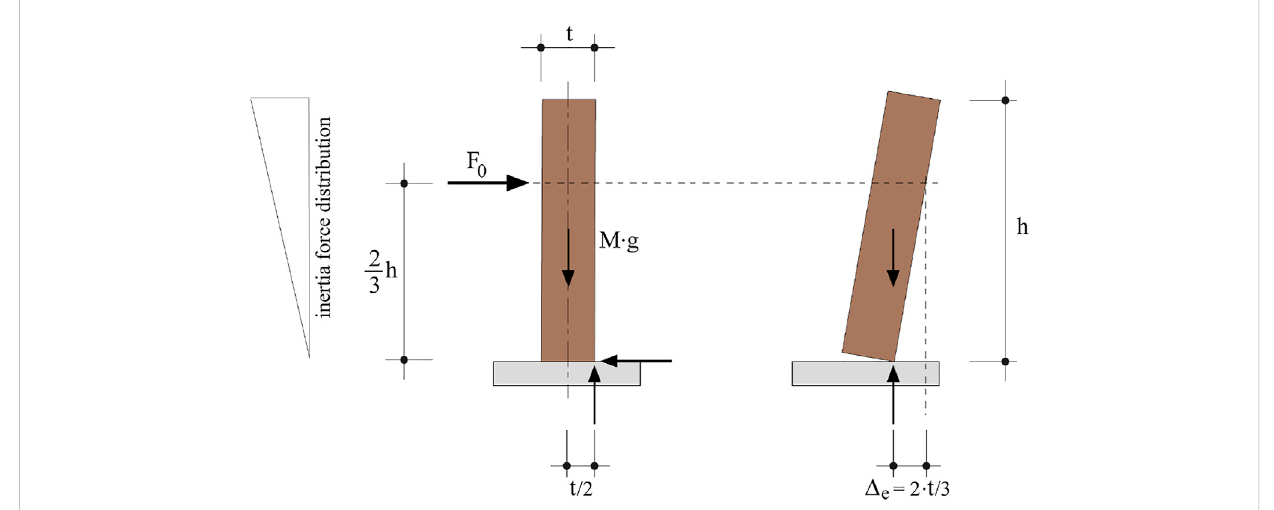
FIGURE 1 Rigid body diagram for the out-of-plane behavior of non-structural cantilevered masonry walls (Doherty et al., 2002).